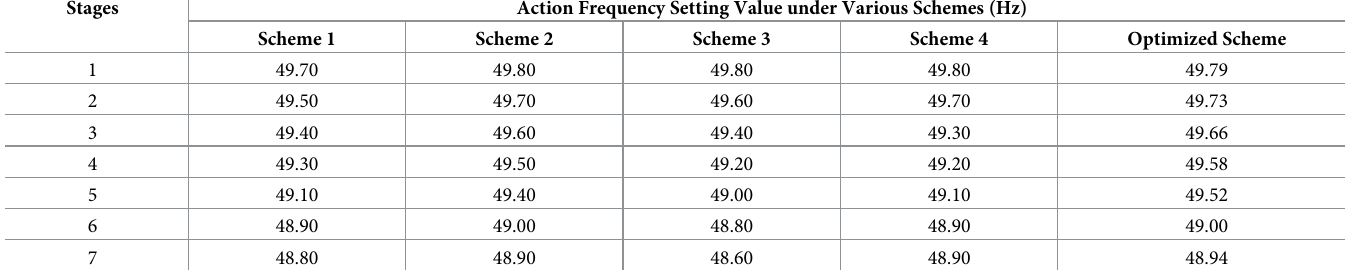
Table 10. Comparison of five schemes (Case 1).